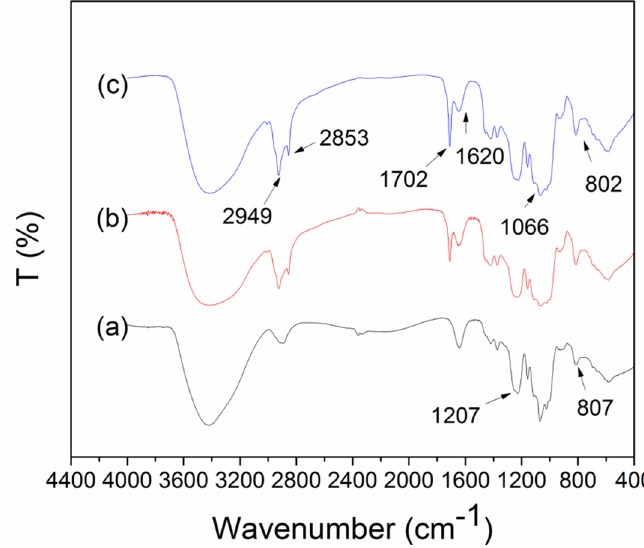
Figure 4. FTIR spectra of CS-OA films (a) 0%; (b) 10%; (c) 25% OA.